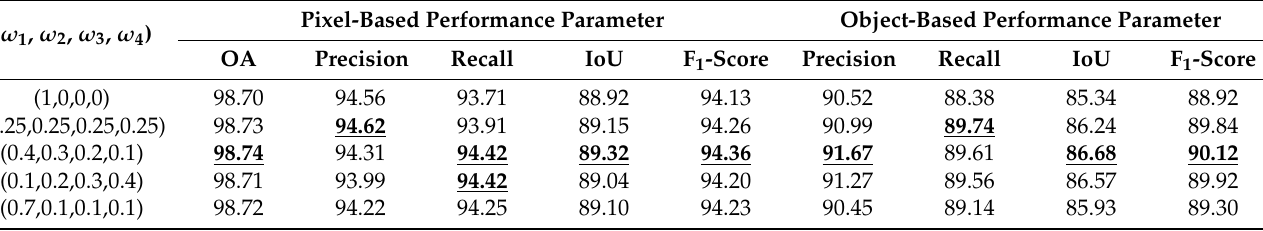
Table 6. Quantitative evaluation (%) of BMFR-Net with different weight combinations of the multilevel joint constraint. The best metric value is highlighted in bold and